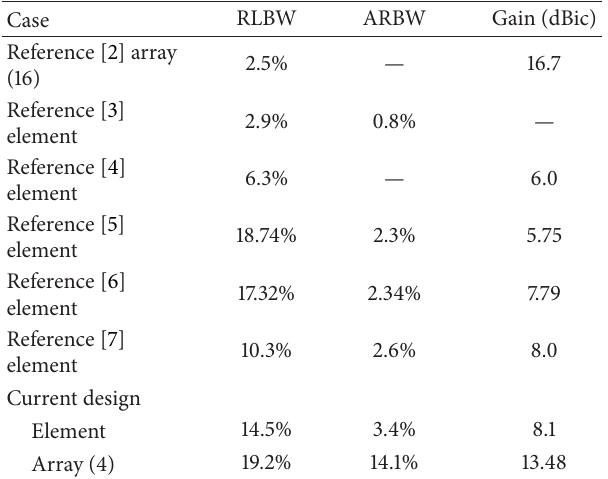
Table 2: Performance comparison with the antennas from refer-